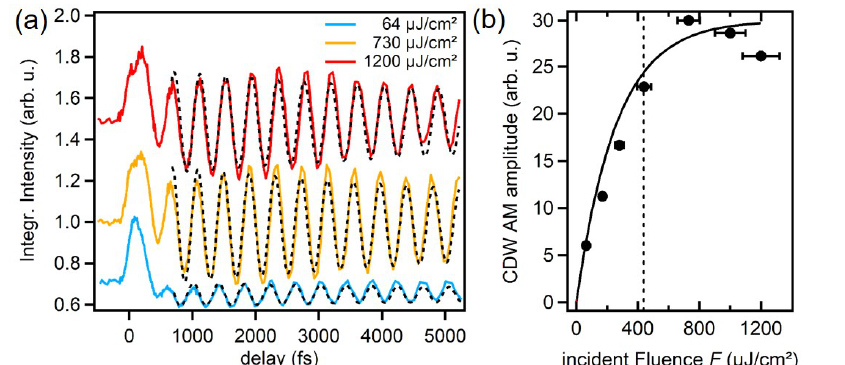
Figure 4. ( a ) Transient spectral intensity in a small energy window ( E − E F = − 65 ... − 45 meV) from which the CDW amplitude mode dynamics can be extracted. Dashed lines are fits to the data, assuming a damped single oscillatory component I ( t ) = A · exp ( − t / τ ) · cos ( ω t + ϕ ) + B with a frequency of 2.5 THz. Typical goodness of fits are χ 2 = 0.15-0.16; ( b ) shows the amplitude A of the oscillation as a function of fluence. The solid black line is the result of the modelling already shown in Figure 3a. Vertical dashed lines indicate the fluence range in which saturation